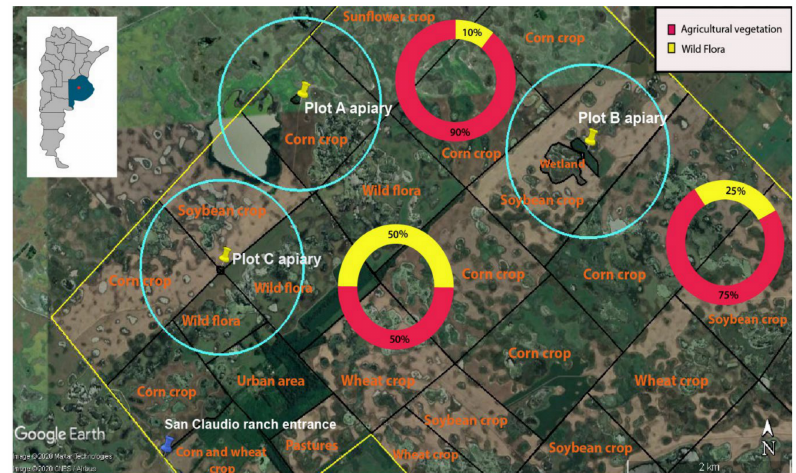
Figure 1. Geographical location of the three studied apiaries on San Claudio Farm, Province of Buenos Aires, Argentina. Light blue circles show 1 km radius around the apiary, indicating the potential foraging area. Circles with a color classification indicate the percentage of cultivated area (in orange, type of crop/vegetation) and in yellow the percentage of uncultivated area with wild flora in each plot (details in Materials and